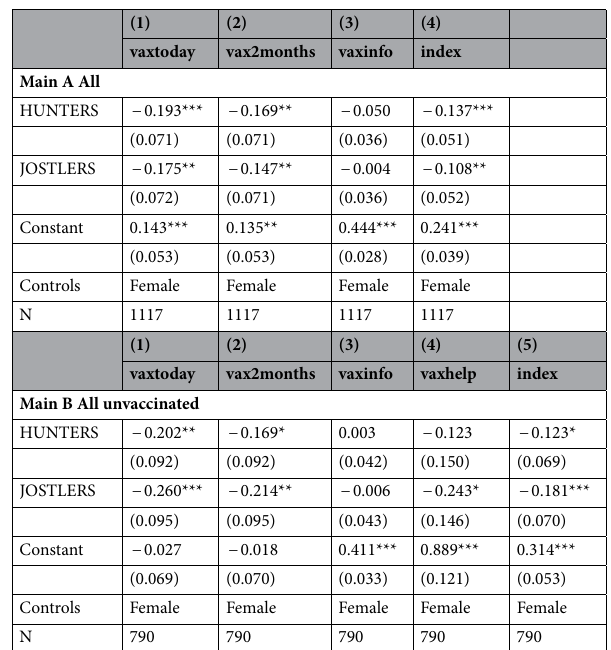
Table 1. Effect of treatments on all outcome variables. OLS regression results. Robust standard errors in parentheses. Significance level *** p < 0.01, ** p < 0.05, * p < 0.1. Dependent variable as stated at top of columns. HUNTERS is a dummy variable equal to 1 if the participant was randomized into the HUNTERS treatment. JOSTLERS is a dummy variable equal to 1 if the participant was randomized into the JOSTLERS treatment. Panel A includes data from all participants in the CONTROL, HUNTERS and JOSTLERS treatments, regardless of vaccination status by the time of survey completion. Panel B include unvaccinated participants